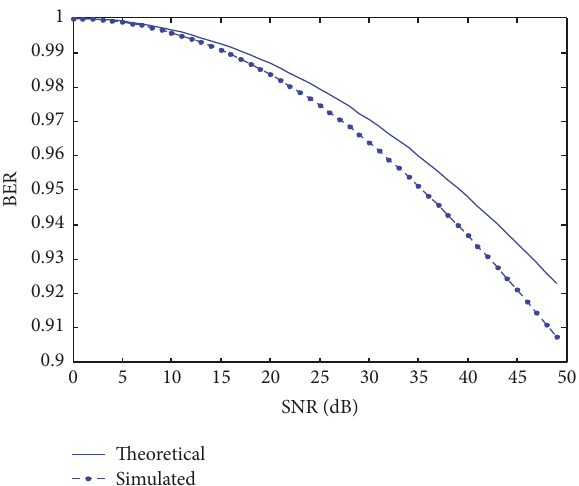
Figure 6: Proposed method